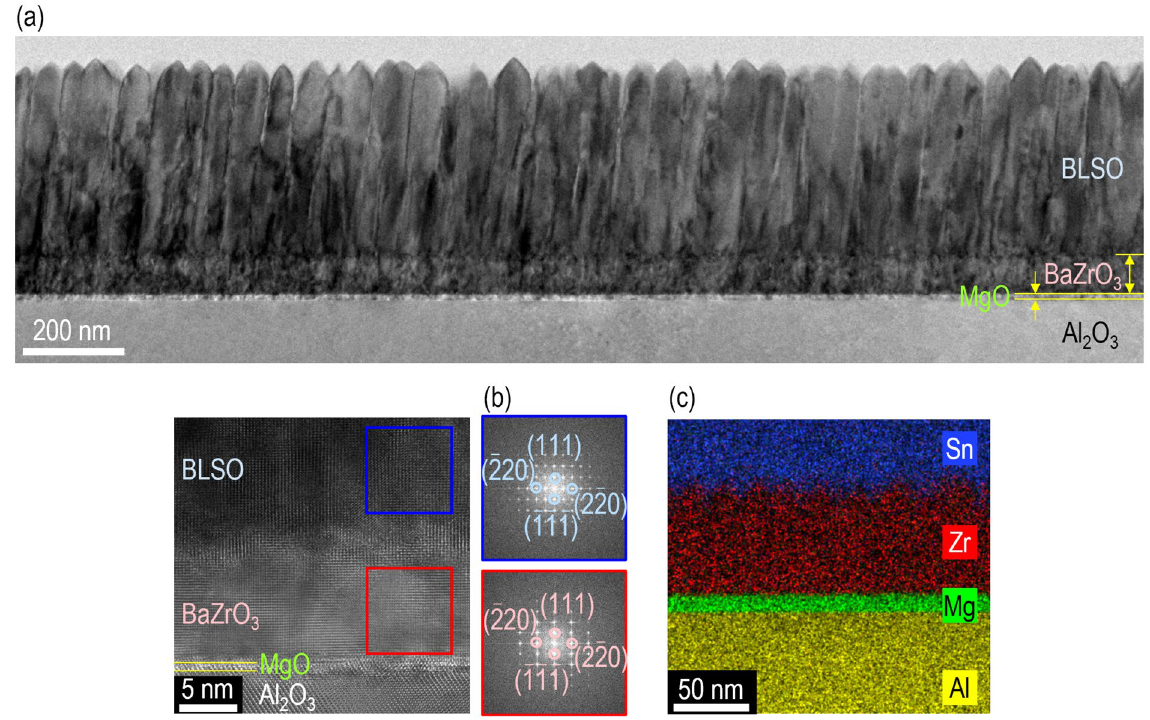
Fig. 2 Nanoscopic investigation of the crystal structure of BLSO BaZrO 3 / MgO ( 0001 ) Al . a The cross-sectional image obtained by transmission electron 2 O 3 microscopy clearly shows the BLSO film, BaZrO 3 /MgO template bilayer, and Al 2 O 3 substrate. b The fast Fourier transformation images at selected areas indicate the (111)-oriented epitaxial growth of the BLSO film and BaZrO 3 template layer. c Energy-dispersive X-ray spectroscopy shows the negligible intermixing of Sn (blue colour), Zr (red), Mg (green), and Al (yellow) atoms between the